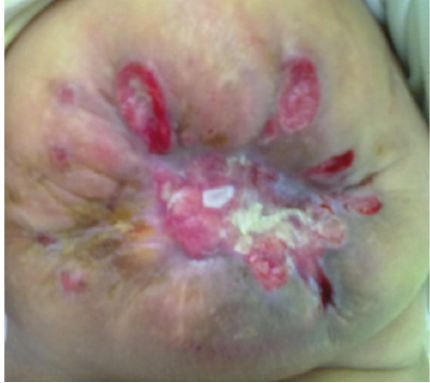
Figure 1: Photograph showing lobulated and ulcerative breast tumor.